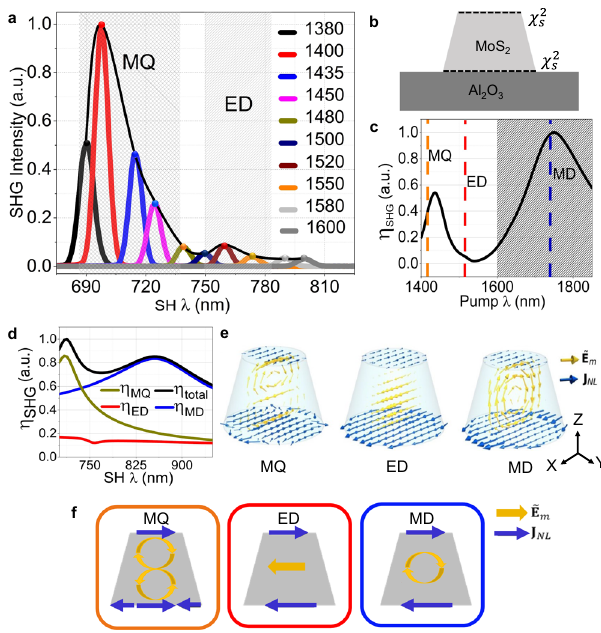
Fig. 5 Second harmonic generation in a TMDC metasurface. a Experimentally measured wavelength dependence of the SHG from metasurface C. The second harmonic generation (SHG) was enhanced in the vicinity of magnetic quadrupole (MQ) and electric dipole (ED). b Schematic showing the locations of the SH current source χ 2 . c Calculated second harmonic generation conversion ef fi ciency ( η ) by employing full- SHG wave nonlinear simulations. The patterned region is the spectral range not accessible by the laser in our experiments. d SHG conversion ef fi ciency calculated using quasi-normal modes couple-mode theory. e Spatial overlap between the induced nonlinear current source J NL and eigen fi elds of the calculated quasi-normal modes ~ E m . f Schematic of the modal overlap of nonlinear current source and eigen fi